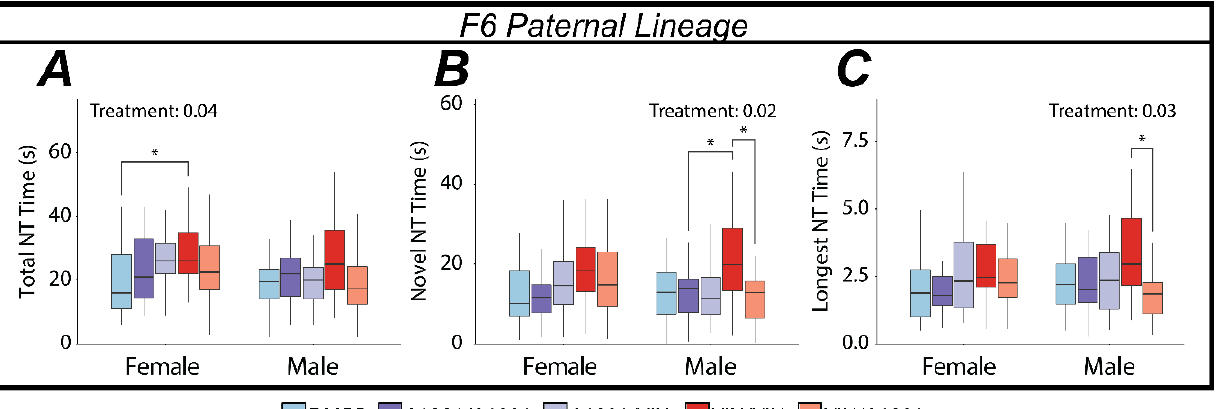
Figure 8. Metrics of nose-touching (NT) in the social novelty test as determined by leveraging machine learning techniques are graphed as box and whisker plots (minimum, 25% quartile, median, 75% quartile, and maximum). Main effects of treatment were determined by a one-way ANOVA within each sex and lineage, and indicated for p < 0.05. Significant post hoc results as determined by Tukey’s HSD and appropriately adjusted for multiple comparisons are indicated with bars connecting the respective groups (* <0.05). ( A ) The only nose-touch metric affected in females was identified in the F6 paternal lineage where a combination of an ancestral and direct exposure of VIN increased total nose-touch time (the sum of familiar and stimulus NT time). ( B , C ) The time spent nose-touching with the novel stimulus animal and the longest nose-touch interaction were both increased in males from the F6 paternal lineage exposed to an ancestral exposure and a direct exposure of VIN. Taken together, these data suggest ancestral VIN exposure may influence social identification or